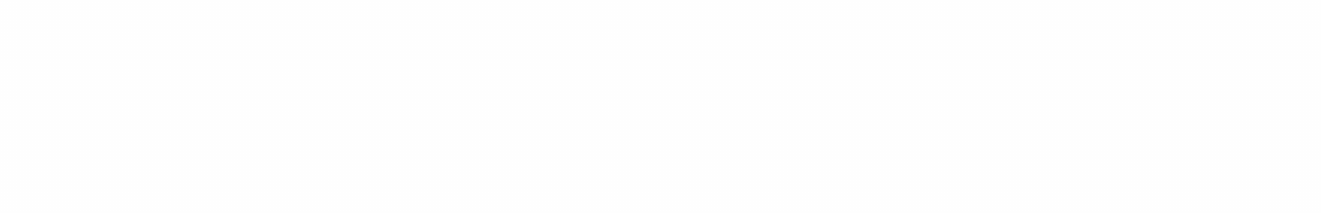
FIGURE 9 With the parameters of Figure 8, by further increasing c, I increases in size approaching the boundary of its basin and a global bifurcation causes the disappearance of leaving N1, N2, and N3 as the only surviving attractors of T 3, shown in (a), obtained for c-0.955, where also a trajectory starting near O is represented, converging to N1. The basins of N, N2, and N3 now share the old white area (see the enlargement in (b)). It is also shown in (b) that these basins are still bounded by the stable sets of the saddle points, while the two branches of the unstable set of each saddle converge to two different attracting nodes. (See Color Plate